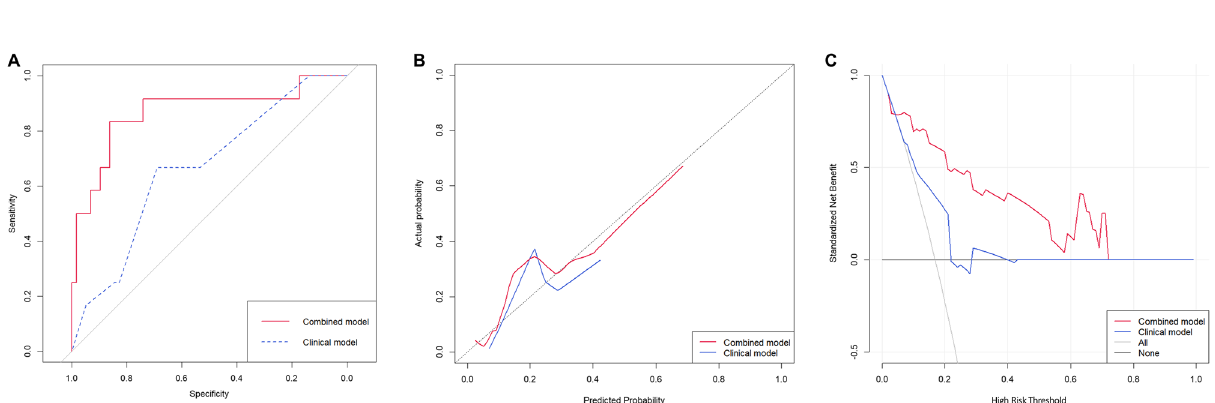
Figure 4. The ROC curve, calibration curve and decision curve of clinical and combined models for distinguishing TN vs. non-TN in the validation cohort. ( A) ROC curve of the clinical model (blue dotted line) and combined model (red solid line). The AUC of the combined model was 0.868 and that of the clinical model was 0.665. The two ROC curves showed significant difference (p = 0.0449). ( B) Calibration curves of clinical and combined models. The 45 ◦ black dotted line expresses the ideal prediction. The combined model is closer to the ideal prediction compared to the clinical model, especially at predicted probability of 0.3 or higher. ( C) Decision curve of clinical and combined models. In the interval between 5 and 71% of threshold probability, the combined model adds more benefit than applying all or none of the patients, and clinical